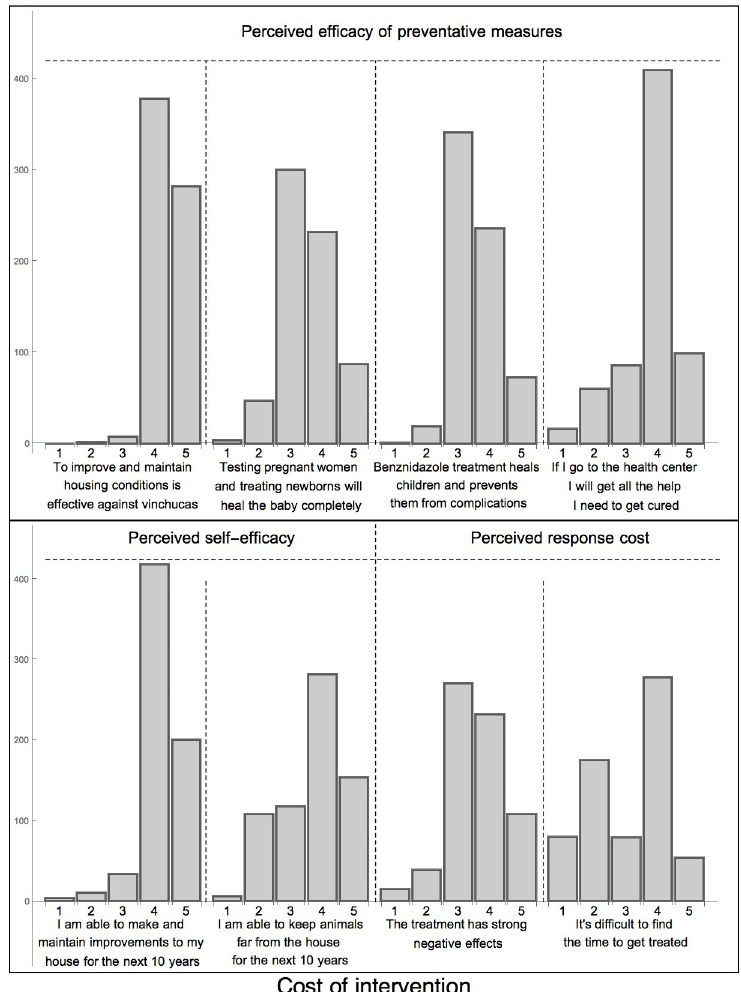
Fig 5. Attitudes of household representatives towards CD related to perceived effectiveness, self-efficacy and response cost. Responses aligned to the PMT coping appraisal pathway. Survey responses on a 1–5 point adapted Likert scale (1 = Strongly disagree, 2 = Disagree, 3 = Don´t know, 4 = Agree, 5 = Strongly agree).